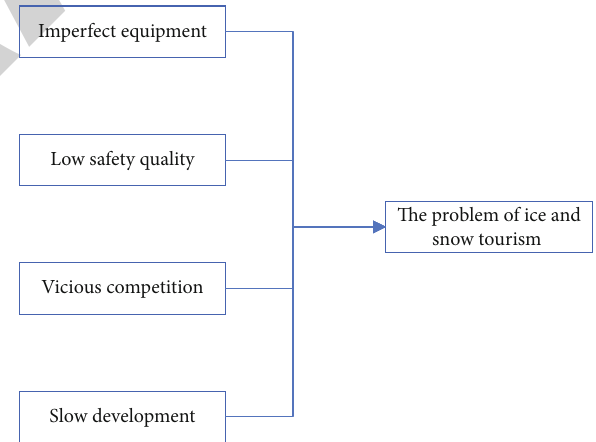
Figure 3: Trends in the number of ice and snow tourists in recent years.